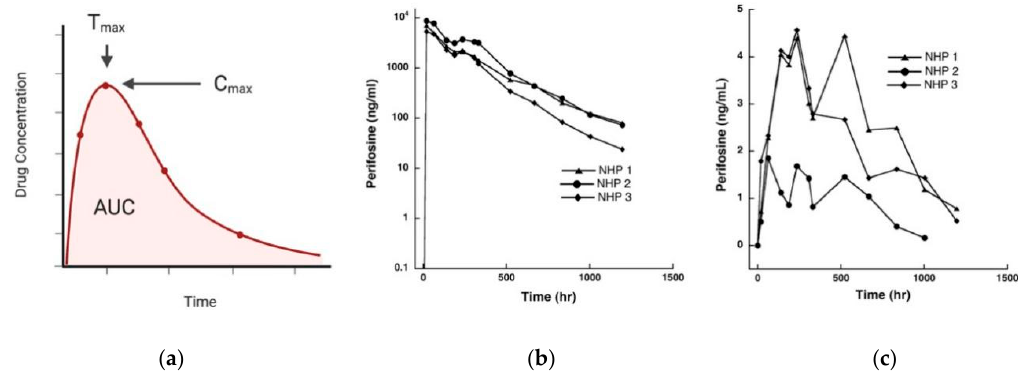
Figure 1. ( a ) Plotting the relationship of drug concentration and time defines the maximal concentration (C max ) and time of maximal concentration (T max ) for a given dose and route administration; ( b ) Experimental data showing drug concentration vs. time plots for perifosine in plasma and ( c ) Cerebrospinal fluid (CSF) after oral dosing to three non-human primates (NHP). Images ( b – c ) re-printed with permission from Cole et al. [33] .